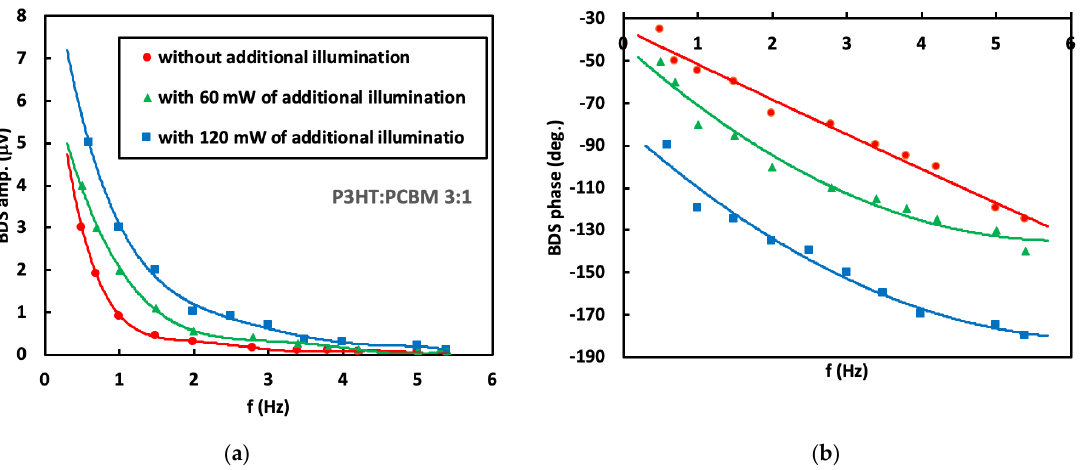
Figure 5. ( a ) Amplitude and ( b ) phase of BDS signal dependence on modulation frequency of TOs for P3HT:PCBM (3:1).